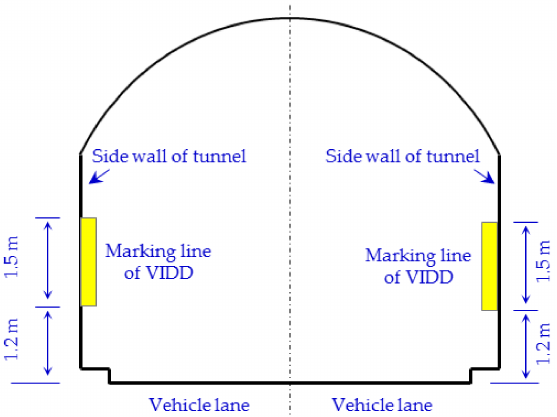
Figure 2. Location of visual-intervention deceleration device (VIDD) on side wall of